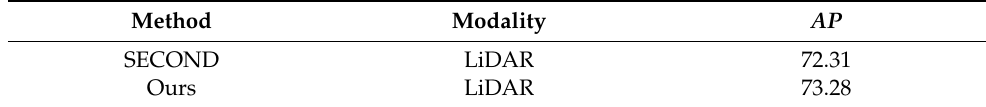
Table 3. Results on the WHUT dataset using the car category.